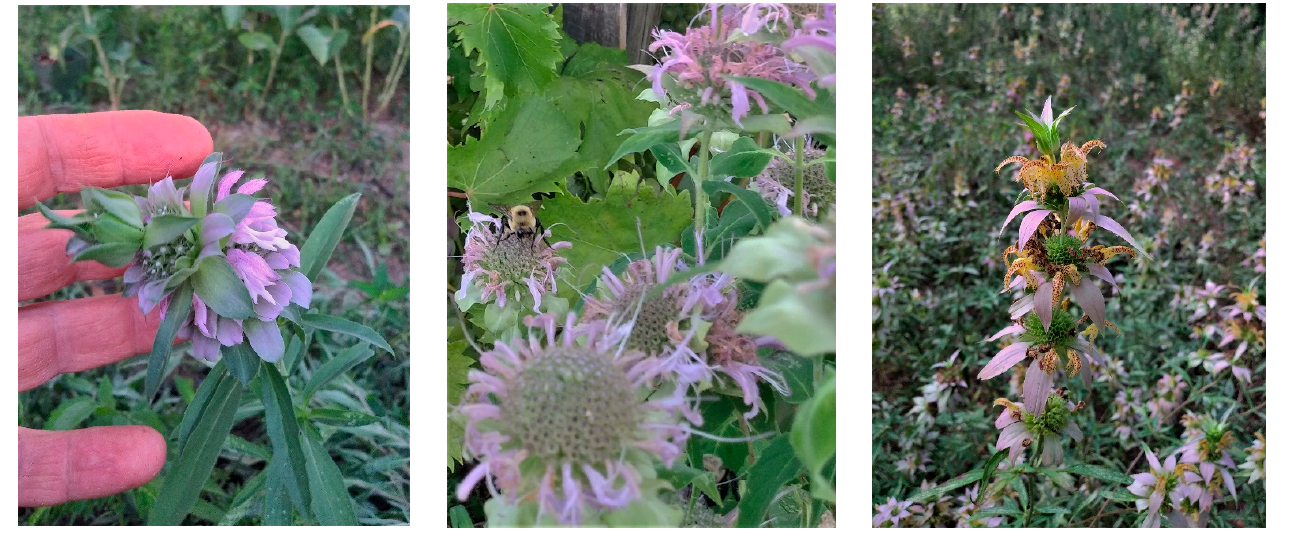
Figure 1. Monarda species discussed in this work (photographs by S. K. L).